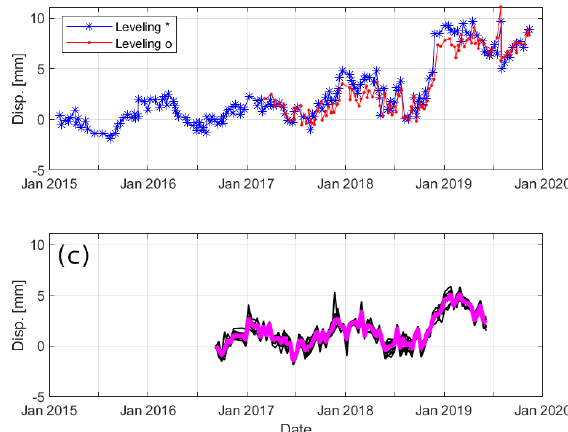
Figure 9. Top: Ground truth from two precise levelling points underneath the building (see Fig. 5). Bottom: Deformation of the (spatially) closest PSI cluster (c) to the levelling points.